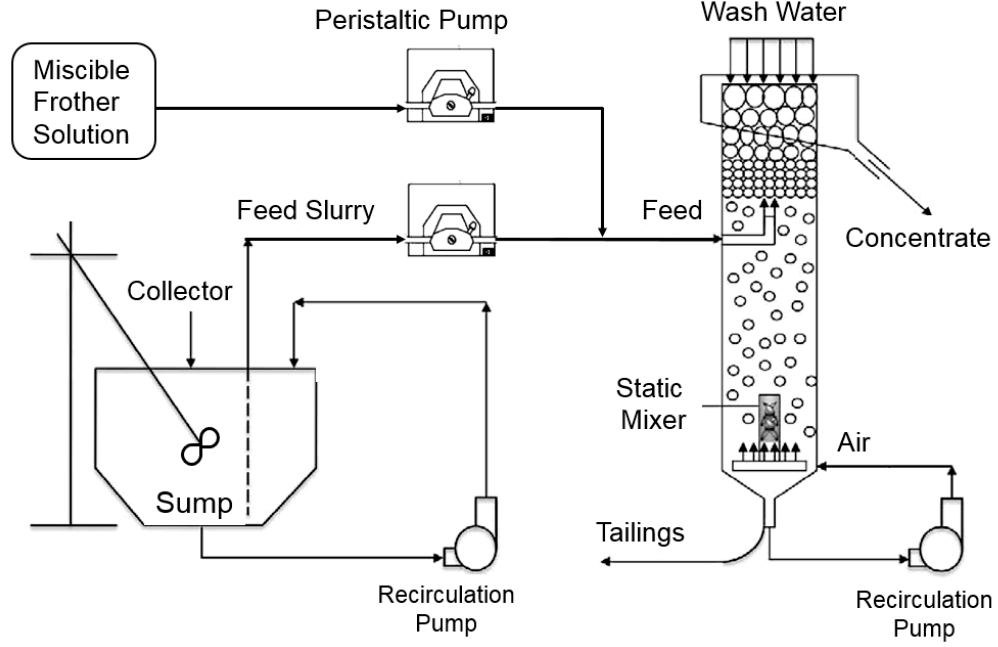
Figure 2. Schematic of laboratory column flotation setup used for the standard testing procedure.